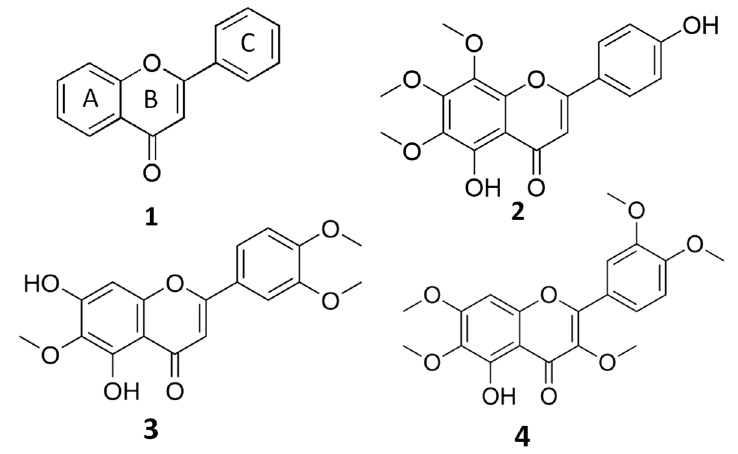
Figure 1. General structure of flavones ( 1 ) and chemical structures of xanthomicrol (XAN, ( 2 )), eupatilin (EUP, ( 3 )) and artemetin (ART, ( 4 )).